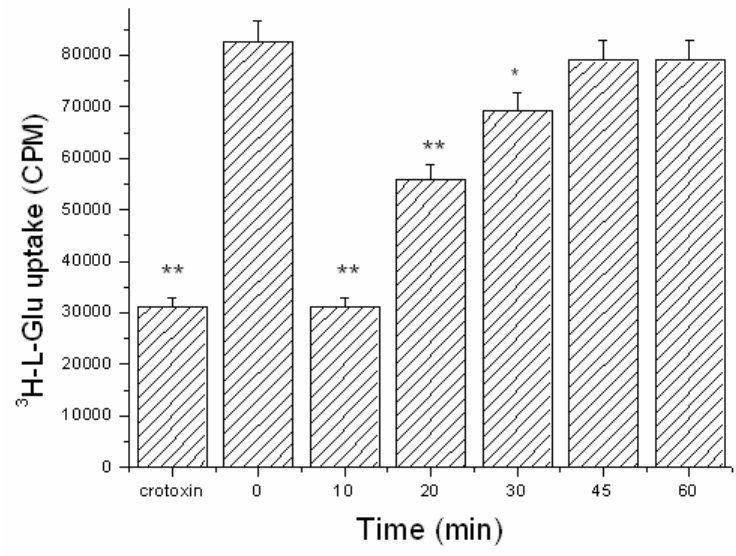
Figure 3. Recovery of C6 glioma cells after incubation with 500 µ M of crotoxin. Cells were incubated for 20 min with the toxin, washed twice with PBS buffer and then incubated again at 37 o C. After 10, 20, 30, 45 and 60 min, the cells were removed and assayed for 3 H-L-glutamate uptake. The word “ crotoxin ” represents inhibition of the neurotransmitter uptake by crotoxin after 20 min of incubation with the toxin (** p < 0.01 ; * p < 0.05